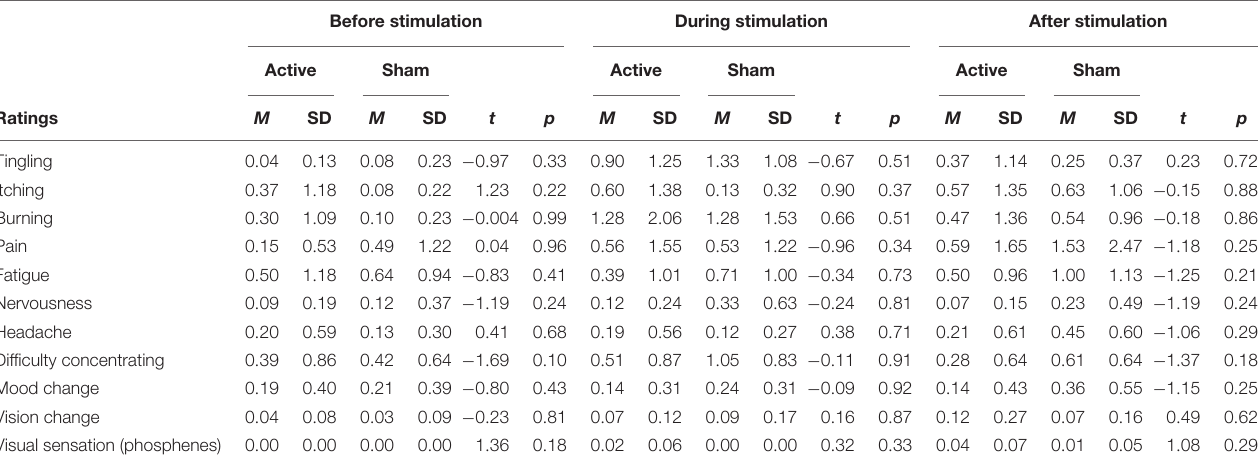
TABLE 4 | Sensation rating (0–10 scale) before, during, and after stimulation. Before stimulation During stimulation After stimulation Active Sham Active Sham Active